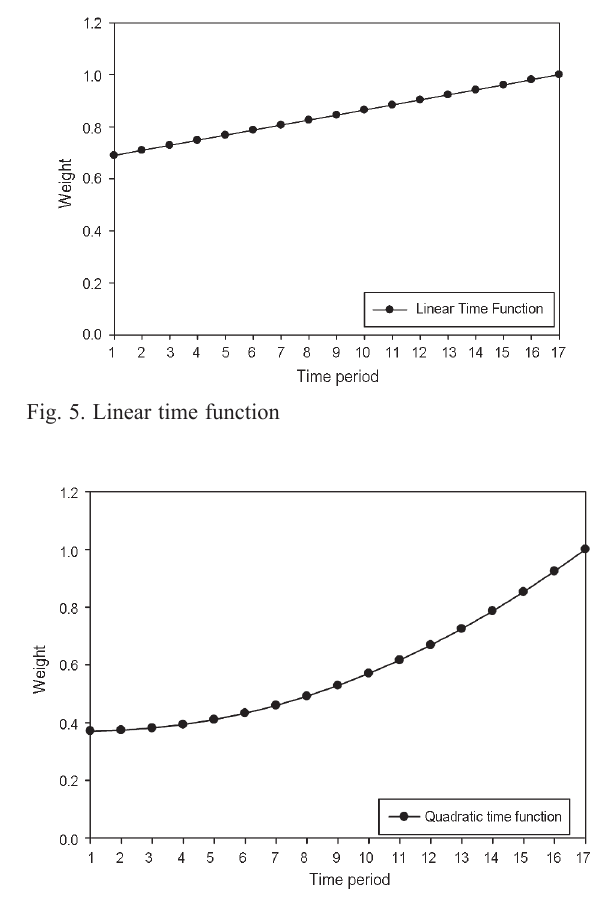
Fig. 6. Quadratic time function